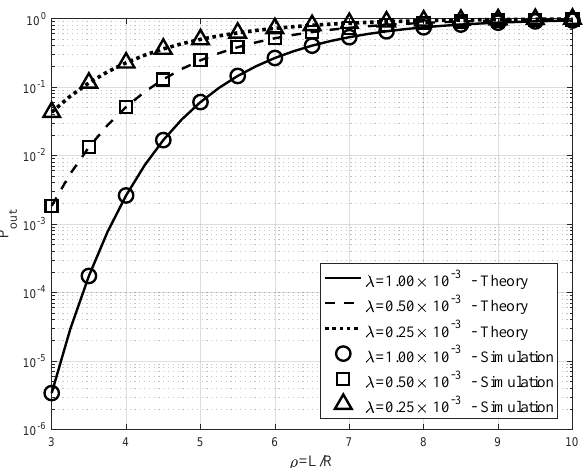
Figure 7. Outage rate versus ρ = L / R with β = 2.5 × 10 − 2 , R = 30 m, and λ = { 0.0025,0.0005,0.0010 } .